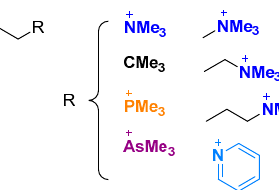
Figure 16. Kme3 analogues recognized by epigenetic reader domain proteins.